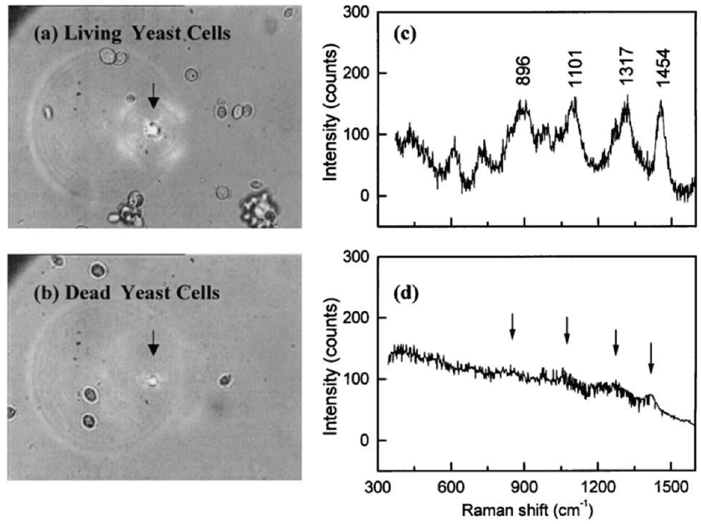
Figure 6. Raman spectra of trapped yeast cells revealing distinct spectra depending on whether the yeast cells are alive or dead [54] (Fair Use according to